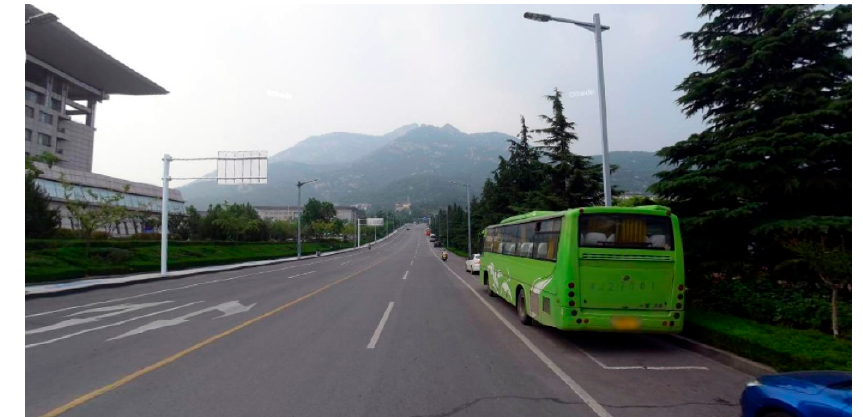
Figure 4. An example of the BSV static image.